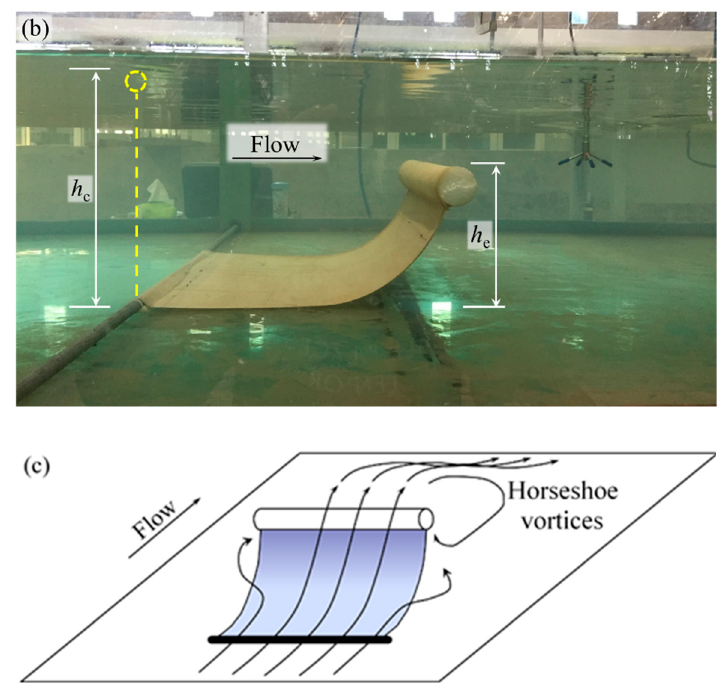
Figure 1. Flexible flow deflector: ( a ) Sketch of flexible flow deflector, ( b ) Photo of flexible flow deflector, ( c ) Sketch of the flow pattern near flexible flow deflector.